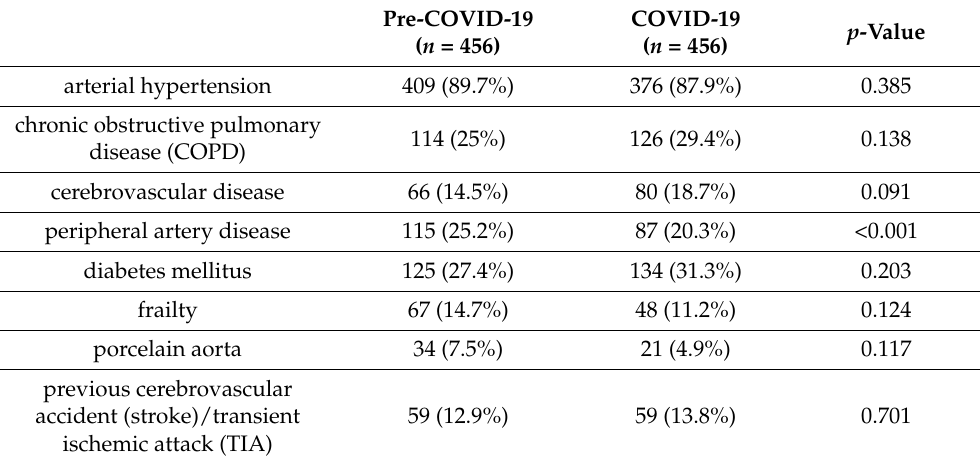
Table 3. Preexisting